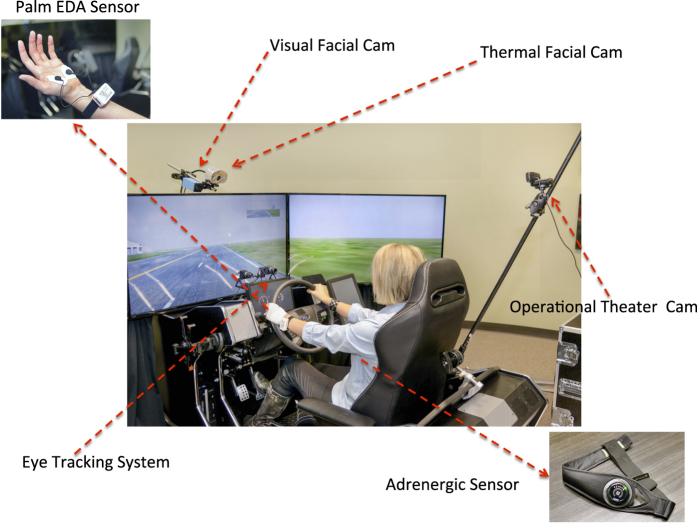
Experimental setup.